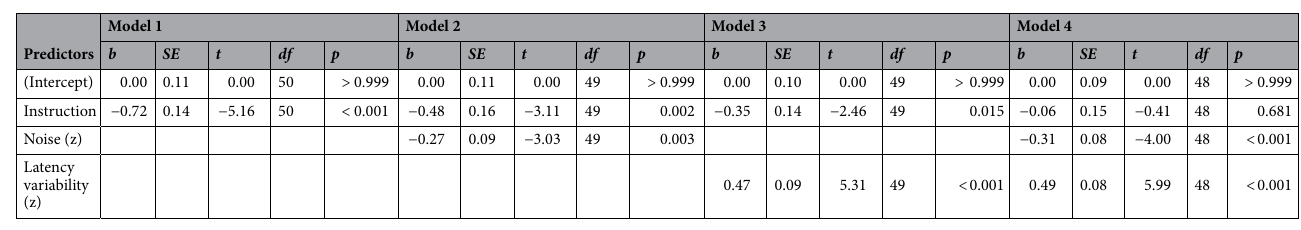
Table 1. Summary of the mixed